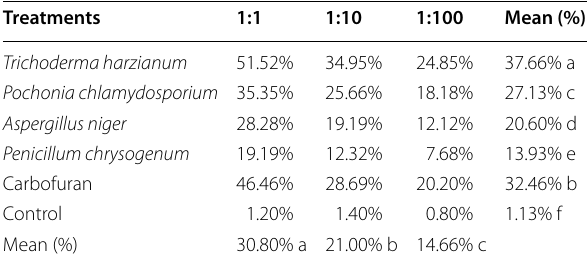
biocontrol agents at varying concentrations at 24